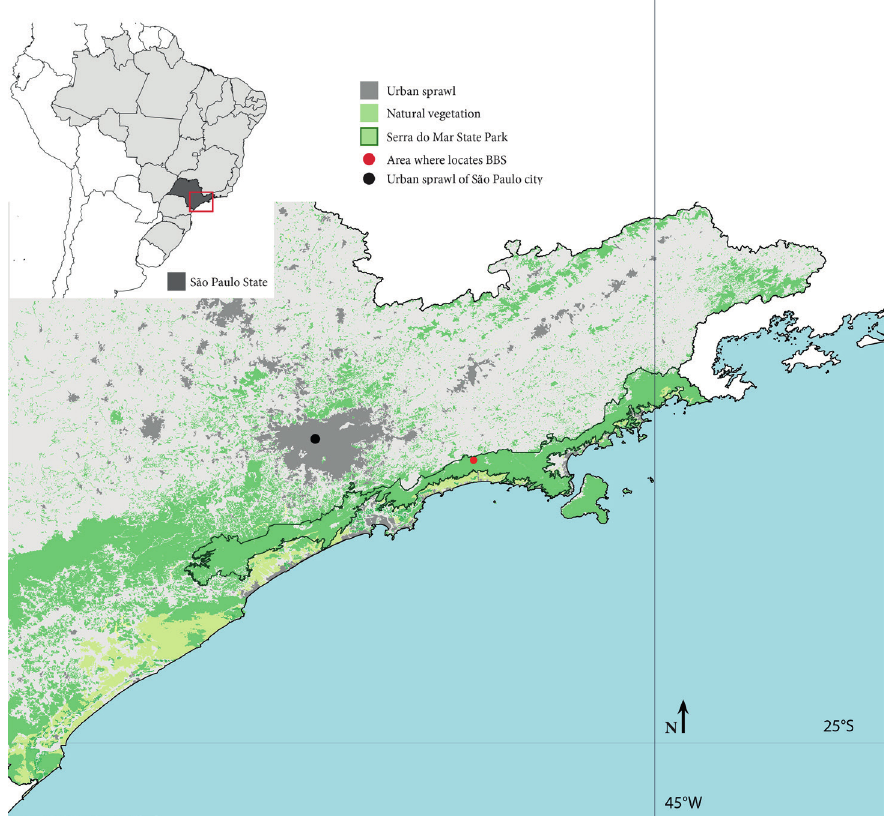
Figure 1 - Sampling area (red dot) within the largest fragment of Brazilian Atlantic rain